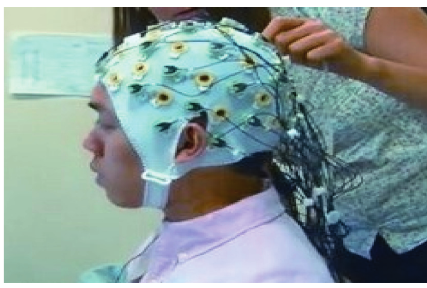
Figure 3: Electroencephalogram test cap for